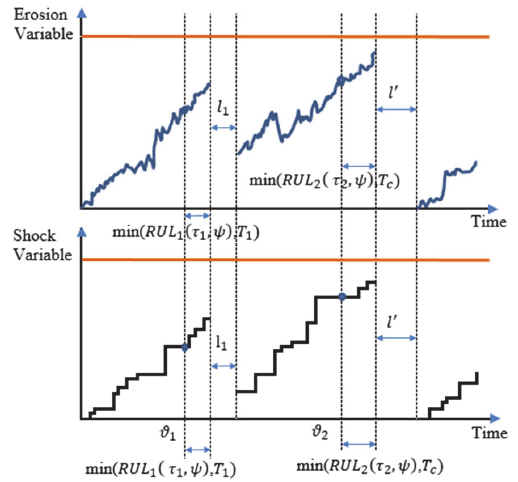
Fig. 5 . The optimal policy for maintenance operations when K =